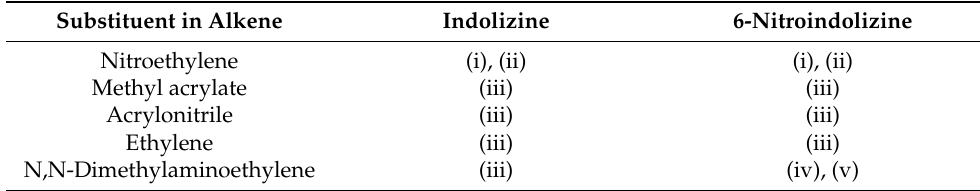
Scheme 50. Abnormal cycloadditon to 6-nitroindolizine.